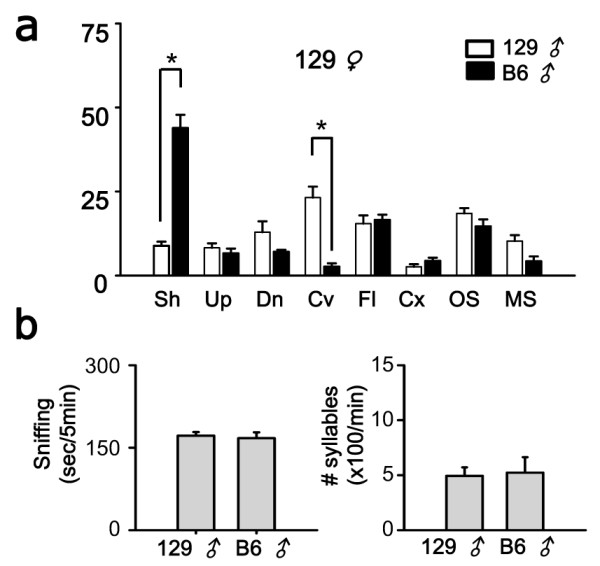
Syllable composition of B6 and 129 males was not affected by the female strain. (a) The ratio of each syllable type for 129 and B6 male mice stimulated by a 129 female. The syllable composition pattern was consistent with Fig. 1 (stimulated by B6 female). (b) Time spent sniffing (left) and total number of syllables (right) during sniffing behavior. B6 and 129 males stimulated by 129 female. * p < 0.01.